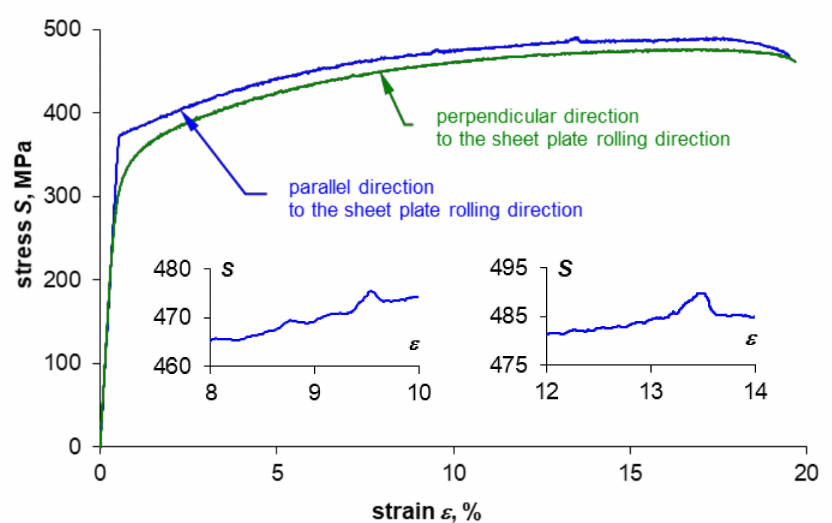
Figure 4. Tensile test curves for specimens made of 2024-T3 aluminum alloy in the form of 0.16” thick sheet plate.